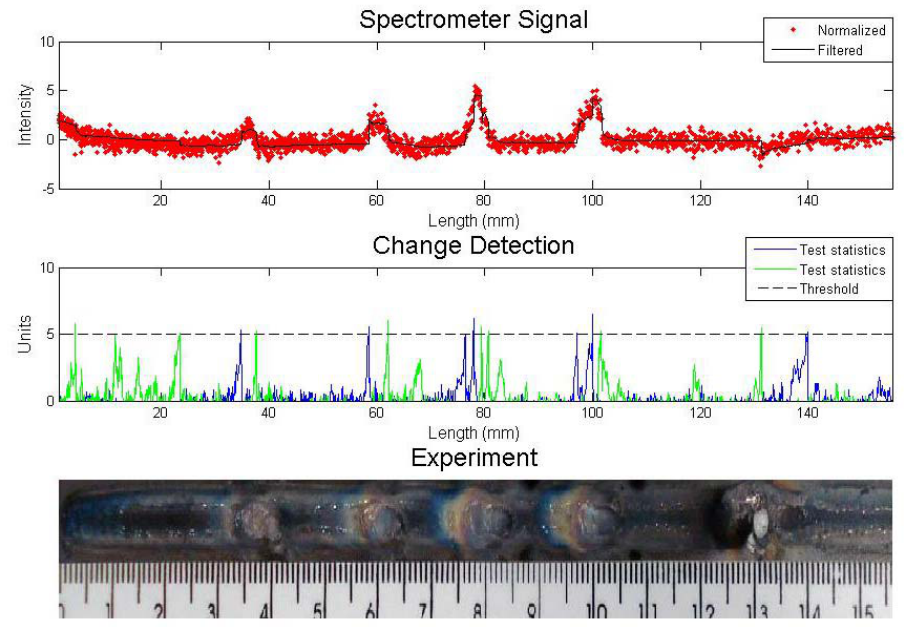
Figure 4. Experiment with metallic and sand inclusions – analysis with Cusum LS